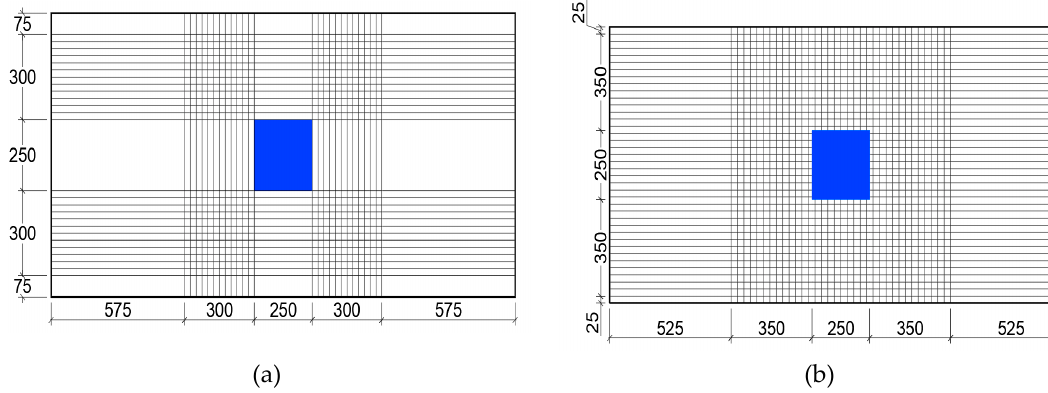
Figure 12. ( a ) Configuration A with four 300 mm wide CFRP sheets and ( b ) configuration B with CFRP sheet covering entire width of slab in one direction [36].